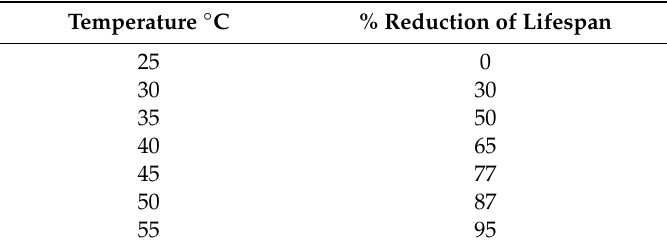
Table 3. E ff ect of temperature on battery lifespan.